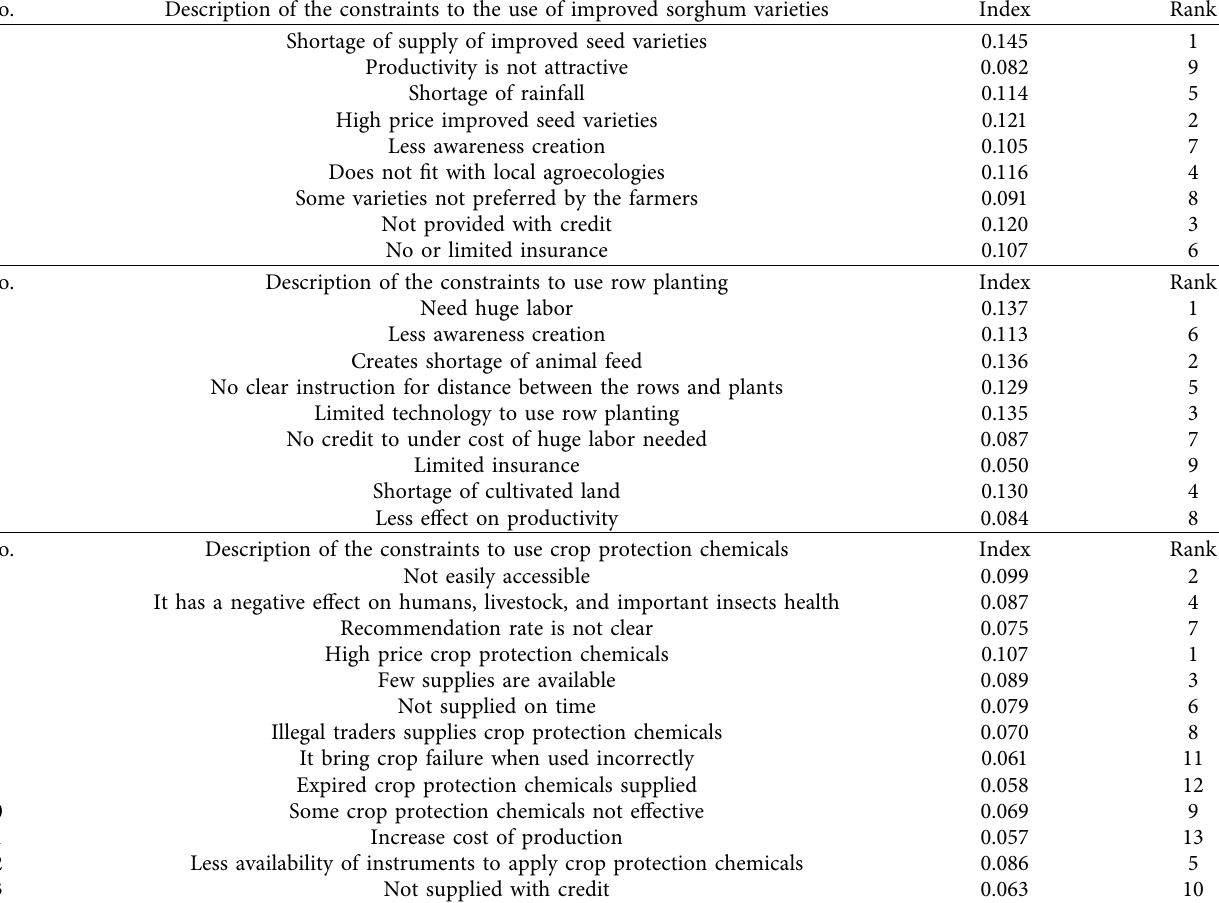
Table 5: Constraints of adoption of organic fertilizer and their rank